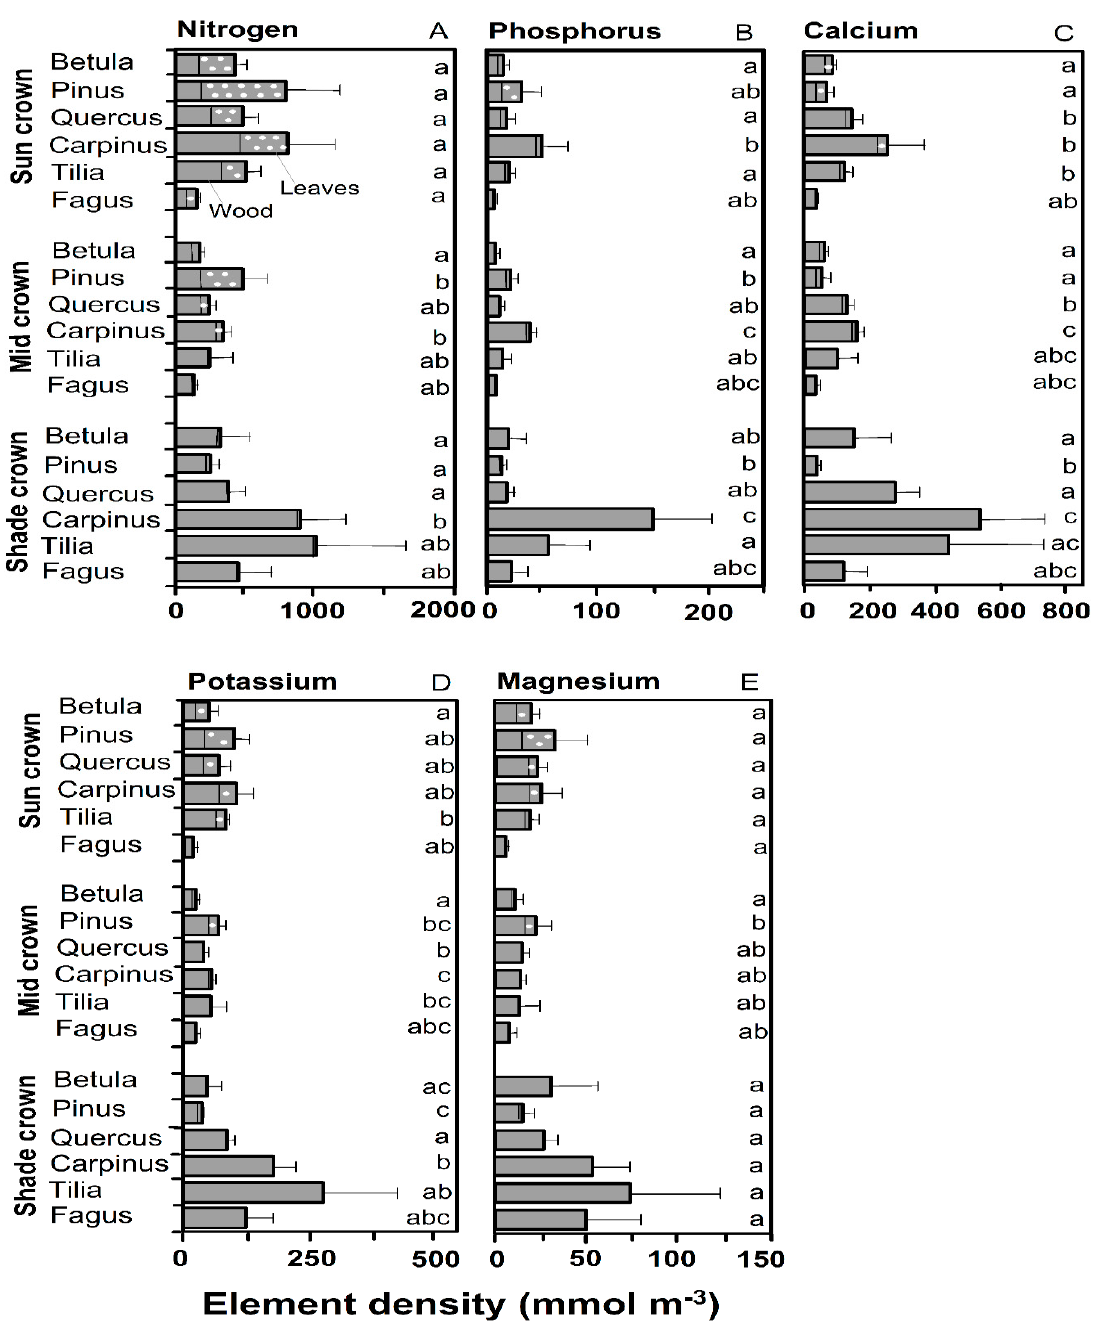
Figure 3. Pools of nitrogen ( A ), phosphorus ( B ), calcium ( C ), potassium ( D ), and magnesium ( E ) in Figure 3. Pools of N, P, K, Mg, and Ca in the biomass (leaves/needles, twigs, branches, stem wood) the biomass (leaves / needles, twigs, branches, stem wood) per unit crown volume in the sun, mid and per unit crown volume in the sun, mid and shade crown of the six tree species (means and standard shade crown of the six tree species (means and standard deviation of each four harvested trees [Fagus: deviation of each four harvested trees [Fagus: nine]). Significantly different means between species nine]). Significantly di ff erent means between species are marked by di ff erent small letters. The leaf are marked by different small letters. The leaf fraction is marked by white dots in the bars. fraction is marked by white dots in the